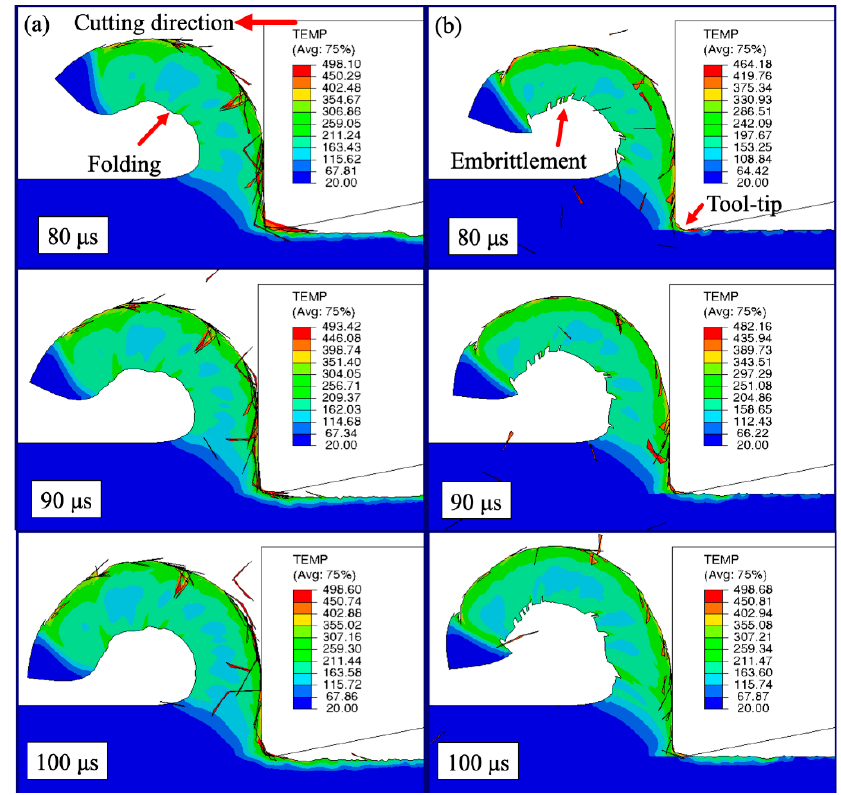
Figure 13. Simulated chip morphology and temperature profile under ( a ) conventional cutting conditions and ( b ) the mechanochemical effect.